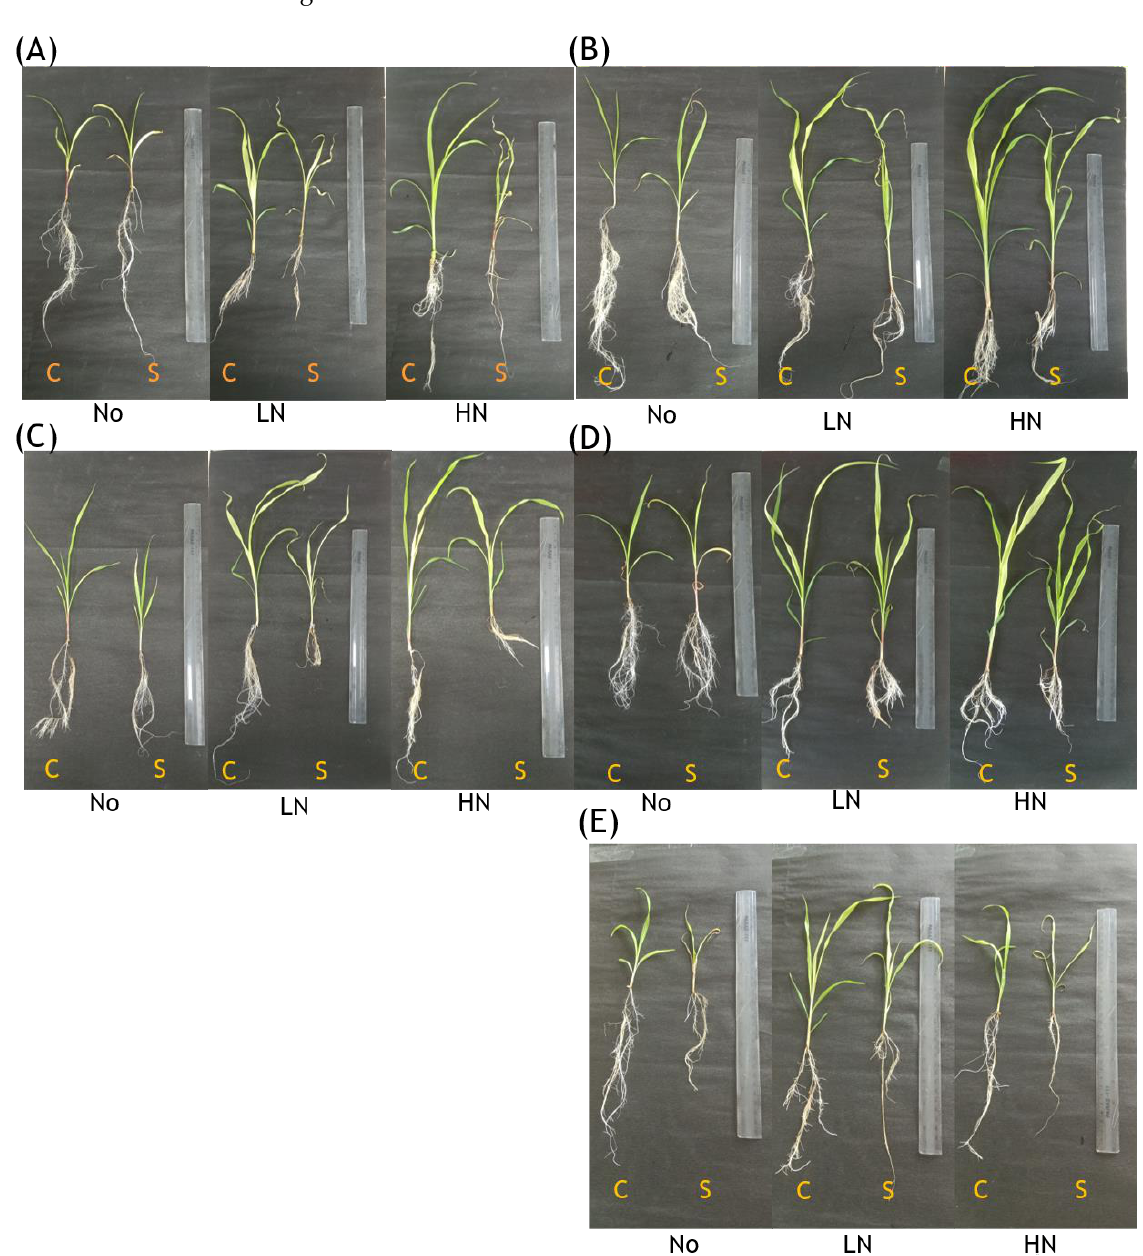
Figure 1. Vegetative plant of pearl millet; control (C) and stress (S) plant in different N treatments (without N (N0), low N (LN), high N (HN)) at day 5 of PEG-6000 (10%) treatment. GHB-719 ( A ); RHB-223 ( B ); HHB-67 ( C ); RHB-234 ( D ); GHB-538 ( E ). Under drought stress conditions, the N0 treatment batch of GHB-538 showed the maximum drop (4.5%) in RWC value, whereas RHB-234 showed the least reduction (0.2%) in RWC value. GHB-538 exhibited the maximum decline in RWC with LN (13%) and HN (11%) treatment batches, while RHB-223, HHB-67, and GHB-719 showed modest reduction (2–5%), with the least (2%) in RHB-234 (Figure 2b).